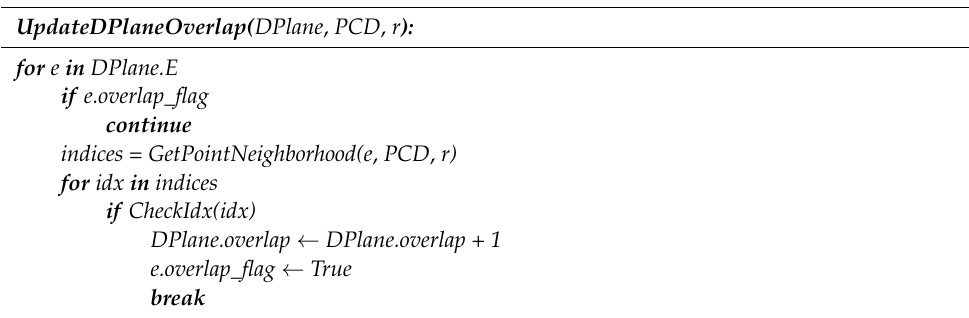
Algorithm 5. An algorithm for updating DPlane’s overlap